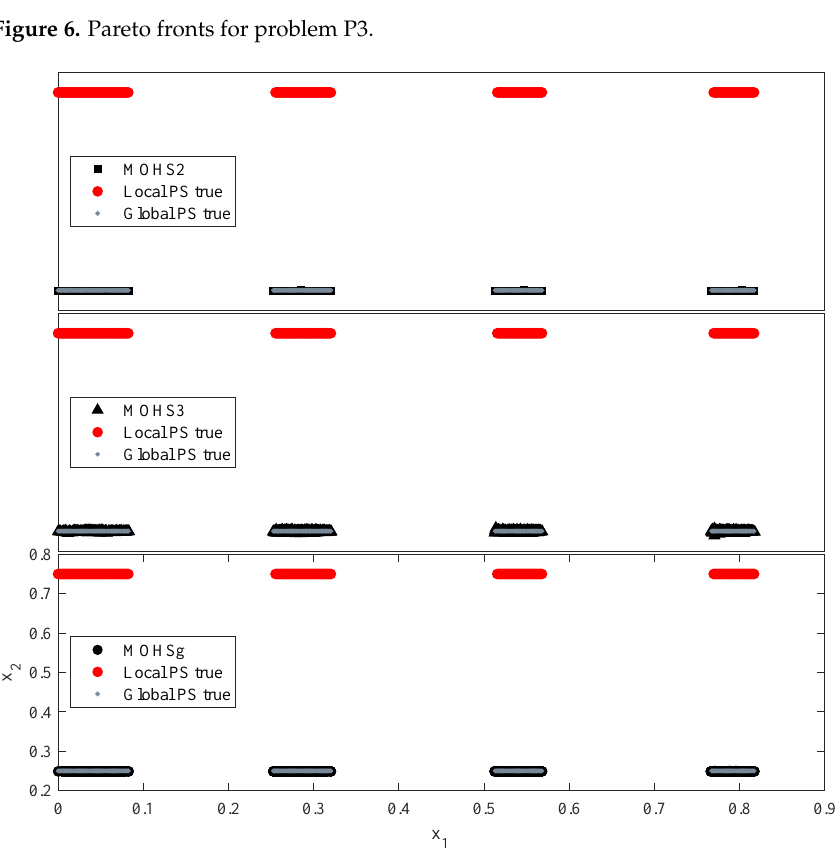
Figure 7. Pareto sets for problem